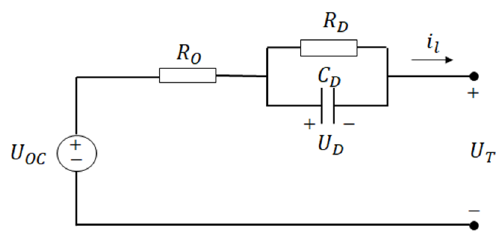
Figure 4. The first-order RC model.